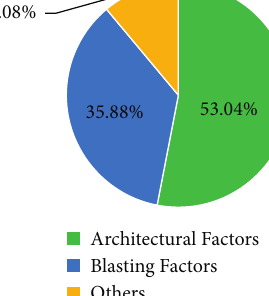
Table 10: Correlation coefficient and ranking of risk factors.